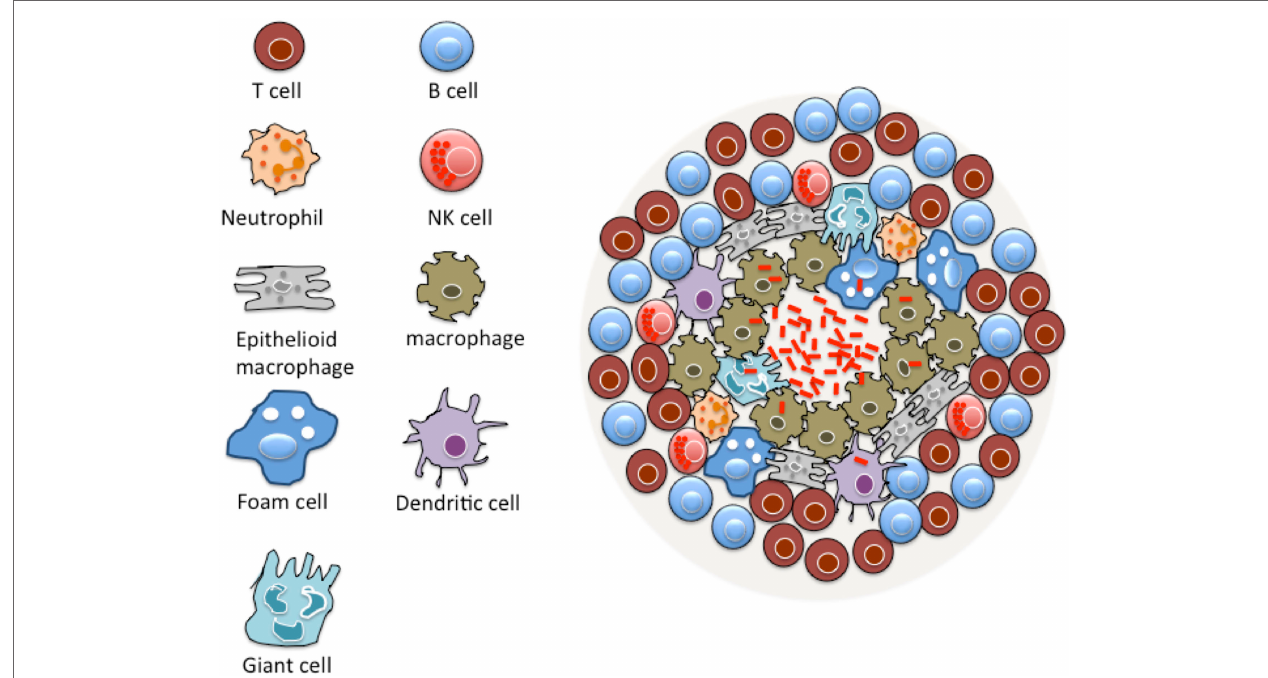
FiGURe 1 | Basic structure of TB granuloma . A granuloma is a compact immunological structure rich with macrophages at the center. Macrophages can undergo specialized transformation differentiating into other cell types, such as epithelioid cells, multi-nucleated giant cells, and foamy macrophages that are accumulated with lipid droplets. A lymphocytic cuff that is largely comprised of B and T cells characterizes the periphery of the granuloma. Many other cell types are known to constitute a granuloma, including neutrophils, dendritic cells, natural killer (NK) cells, and